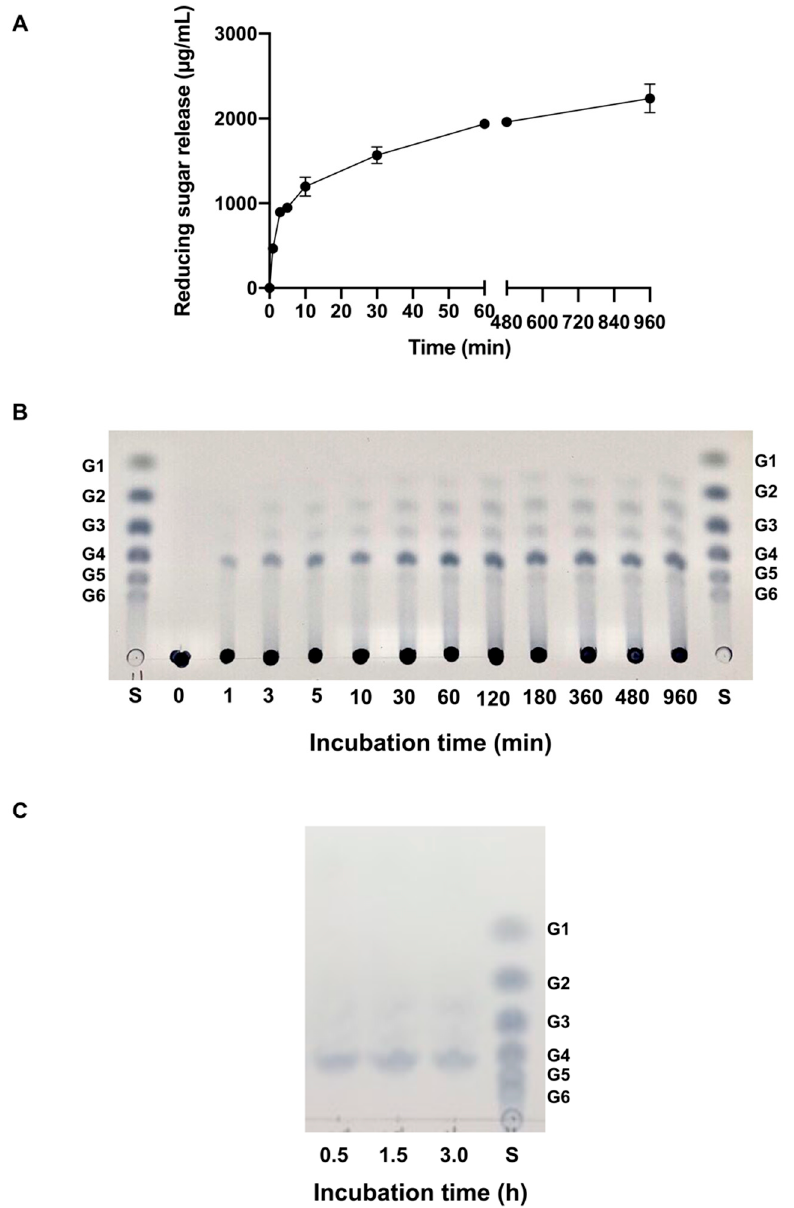
Figure 4. ( A ) Time course of reducing sugar release by 0.25 µM Calk GH9T using CMC as the sub- strate. The hydrolysis reactions between 60 to 480 min were analyzed; however, the X-axis break was used to enhance the readability for the chart. ( B ) TLC analysis of the hydrolysis products using CMC as the substrate. ( C ) TLC analysis of soluble sugars derived from RAC hydrolysis by 1.0 µM Calk GH9T. The enzymatic reactions of CMC and RAC were performed at pH 7.4 and 55 °C. The samples of soluble sugars from RAC hydrolysis were concentrated by evaporation prior to being spotted on TLC. S, standards of glucose and cellodextrins with a degree of polymerization of 2–6 (G2–G6).